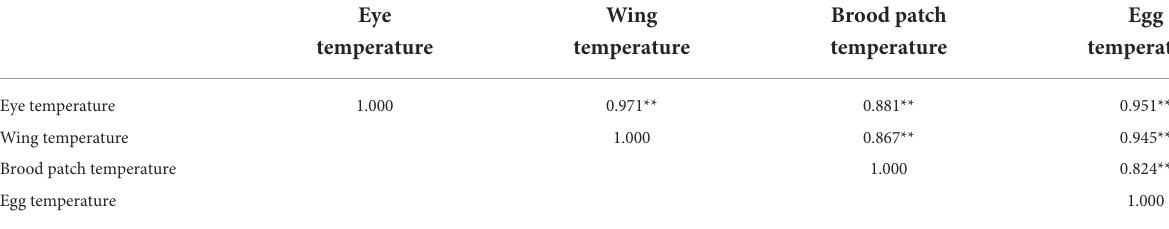
TABLE 3 Pearson’s correlation between surface body temperatures of the broody hens and the temperature of the brooded eggs.